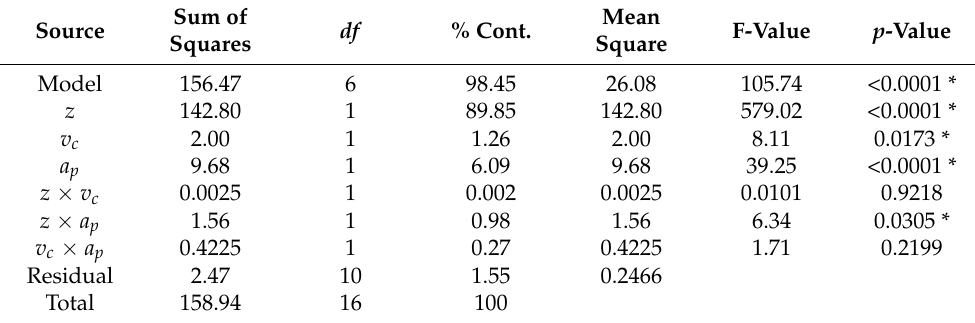
Table 7. ANOVA for cutting temperature (*: significant, p -value <